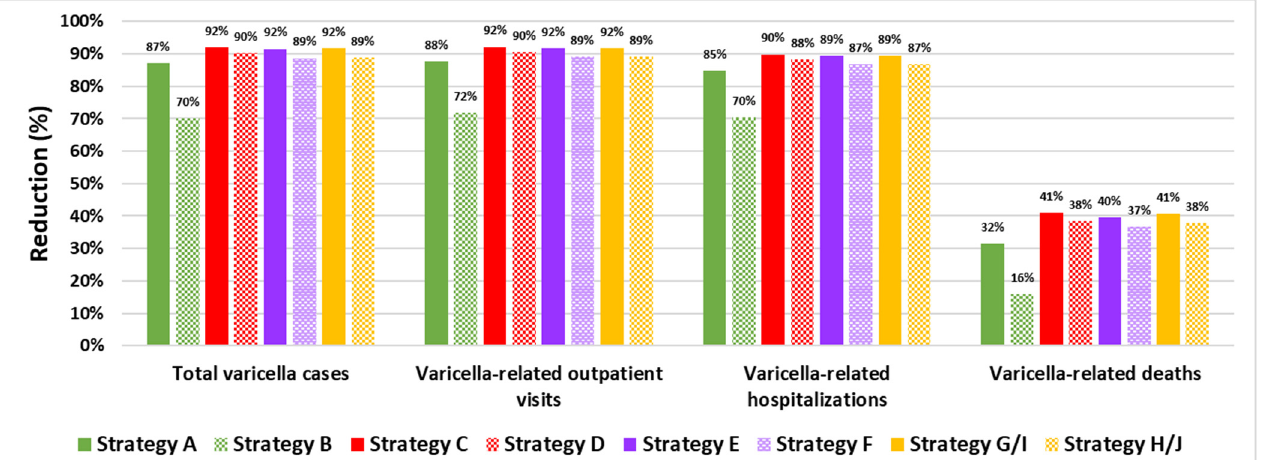
Figure 2. Percentage reduction in varicella health outcomes with various UVV strategies in compar- ison to a no-UVV strategy.